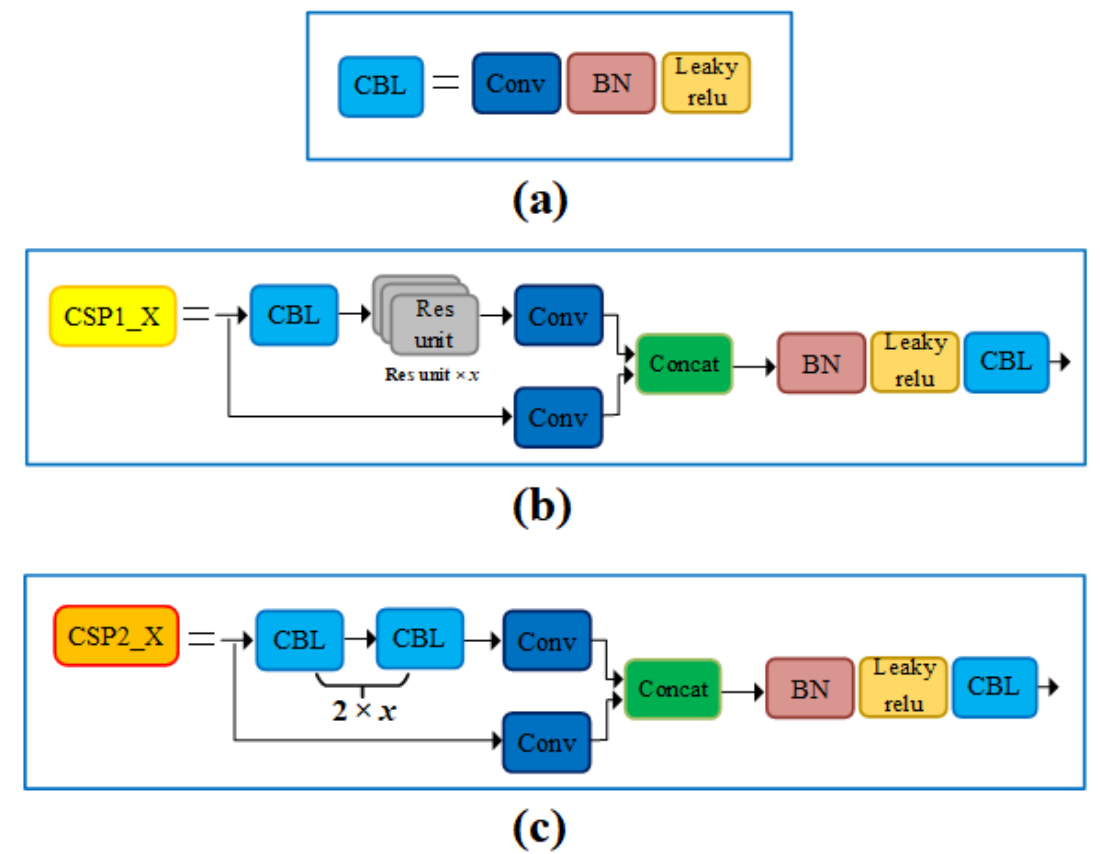
Figure 8. ( a ) CBL structures, ( b ) CSP1_X structures, and ( c ) CSP1_X structures.